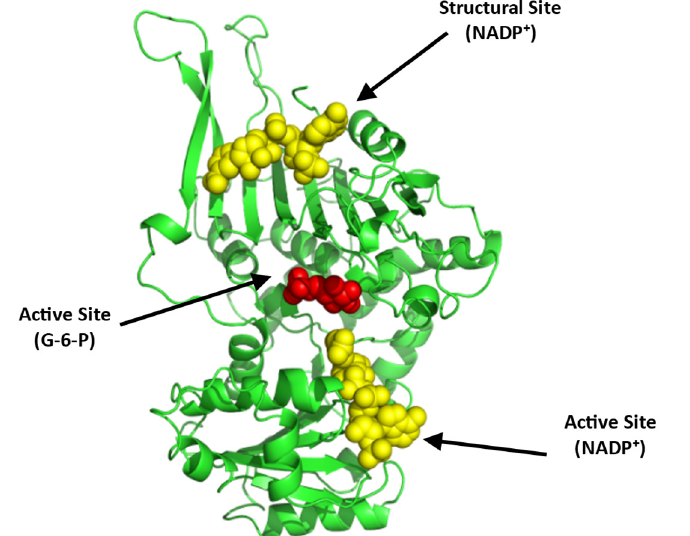
Figure 13. Crystal structure of G6PD (monomer), showing the active site with bound G-6-P (red sphere) and NADP ⁺ (yellow sphere) and a structural site, also with bound NADP ⁺ (yellow sphere). The two G6PD crystal structures (PDB: 2BHL and 2BH9) were superimposed using PyMOL to illustrate all the possible binding sites of G6PD. The subunit is shown in ribbons and colored green.